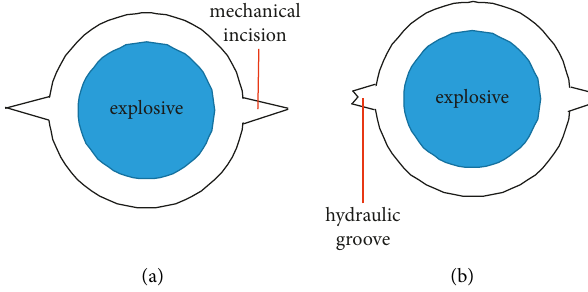
Figure 4: Schematic diagram of grooving in surrounding rock.